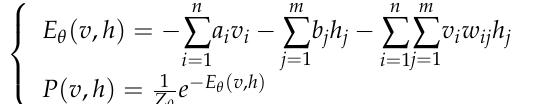
Figure 9. The structure of DBN-DNN. DBN consists of multiple stacked Restricted Boltzmann Machine (RBM) units; each RBM consists of a visible layer and a hidden layer, and the neurons of the visible layer and the hidden layer are fully connected in both directions. The RBM is an energy model where the energy function is defined as E θ ( v , h ) for a set of state quantities ( v , h ), and the joint probability distribution of the hidden layer and the visible layer is defined as P ( v , h ).